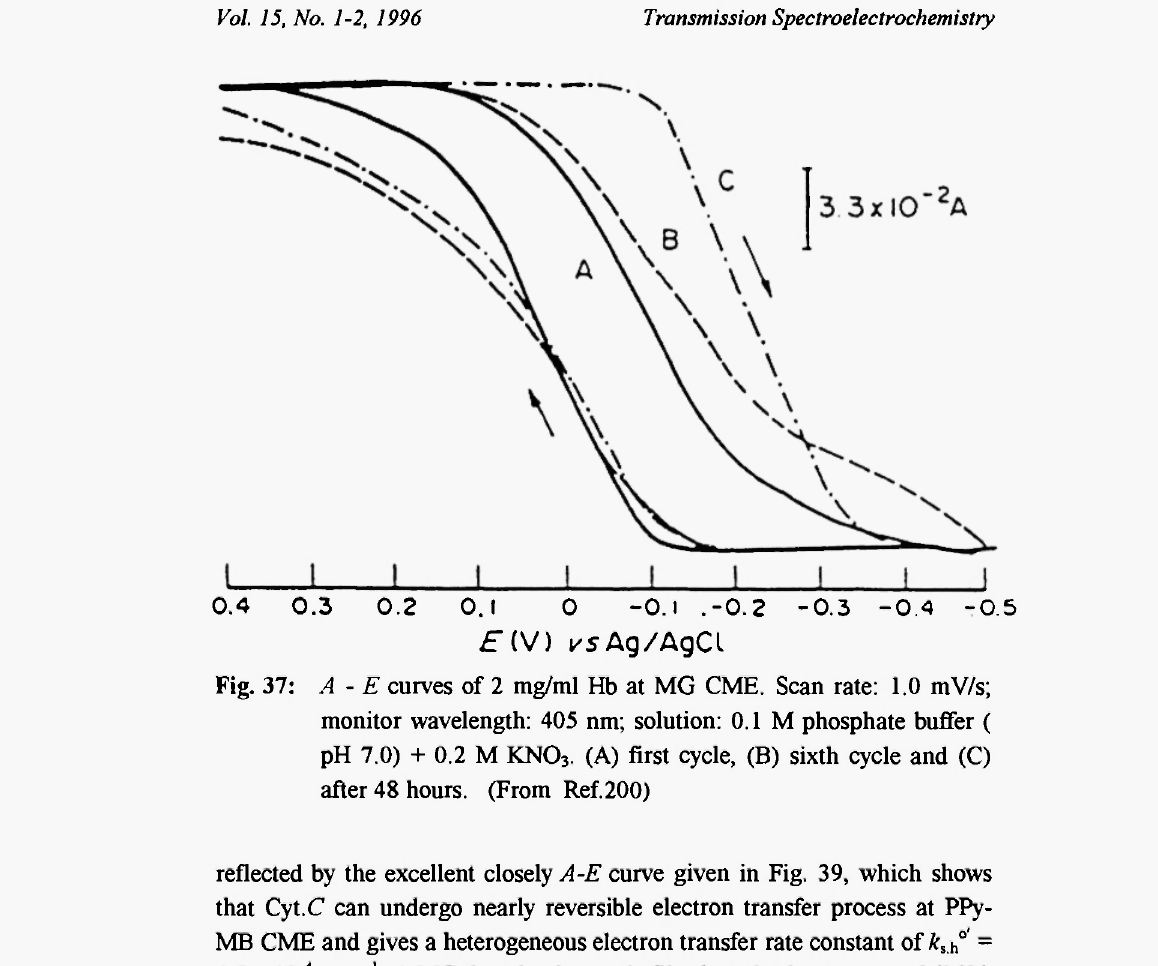
Fig. 37: .4 - Ε curves of 2 mg/ml Hb at MG CME. Scan rate: 1.0 mV/s; monitor wavelength: 405 nm; solution: 0.1 Μ phosphate buffer ( pH 7.0) + 0.2 Μ KN0 3 . (A) first cycle, (B) sixth cycle and (C) after 48 hours. (From